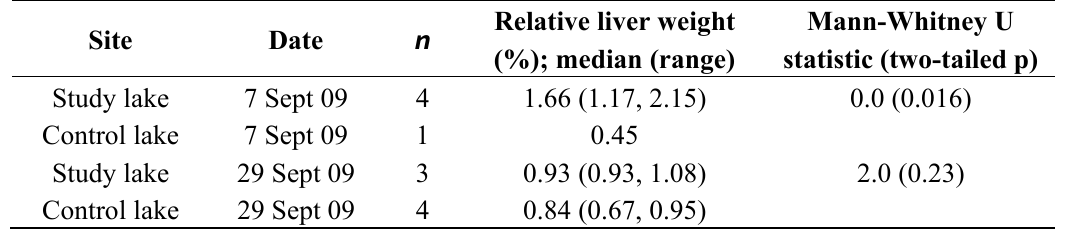
Table 4. Relative liver weights of mullet captured on two occasions from the study lake and nearby reference